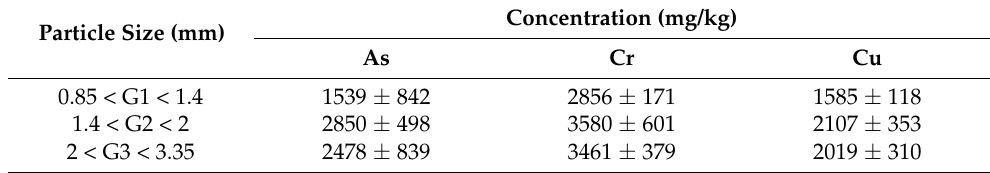
Table 3. The concentration of metals in CCA-treated wood samples for the different particle